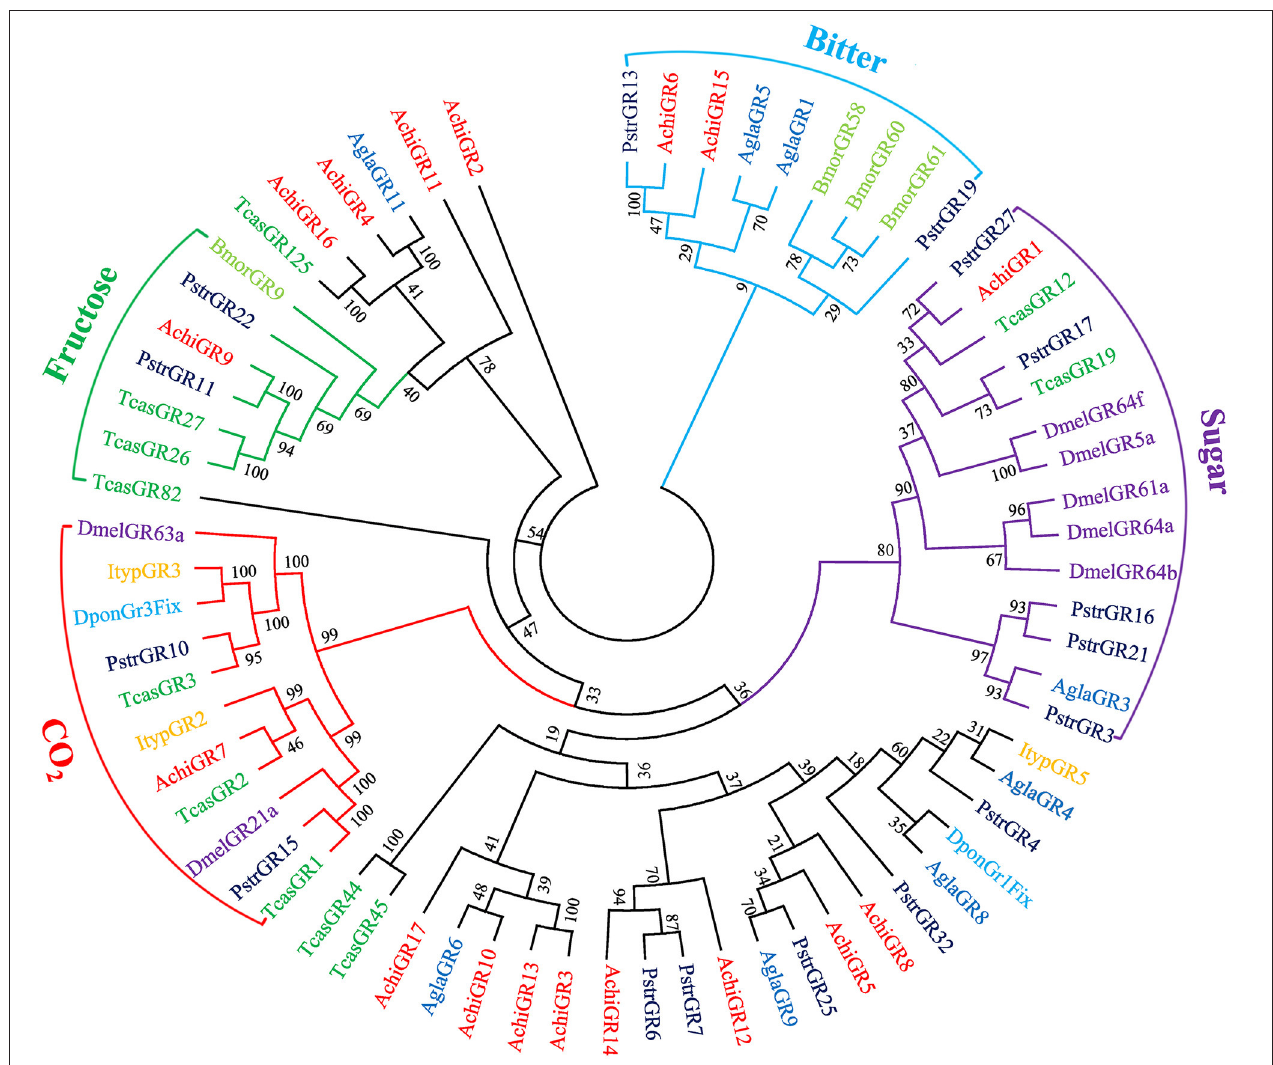
FIGURE 3 | Phylogenetic tree of putative gustatory receptor (GR) genes. The tree was constructed using MEGA6 with Neighbor-joining method. Achi: A. chinensis ; Tcas: T. castaneum ; Agla: A. glabripennis ; Dpon: D. ponderosae ; Ityp: I. typographus ; Pstr: P. striolata ; Dmel: D. melanogaster ; Bmor: B. mori